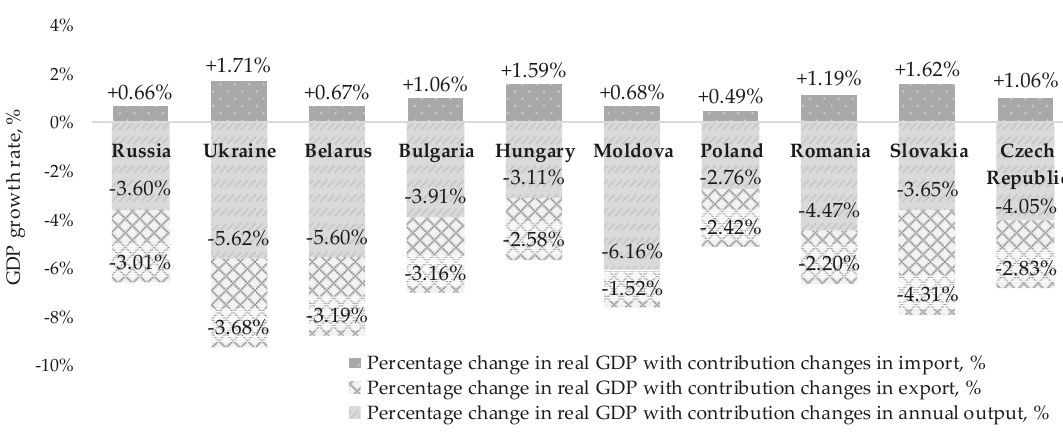
Figure 2. Impact of factors determining the change in GDP in Eastern Europe in 2020 under the impact of COVID-19 epidemic.